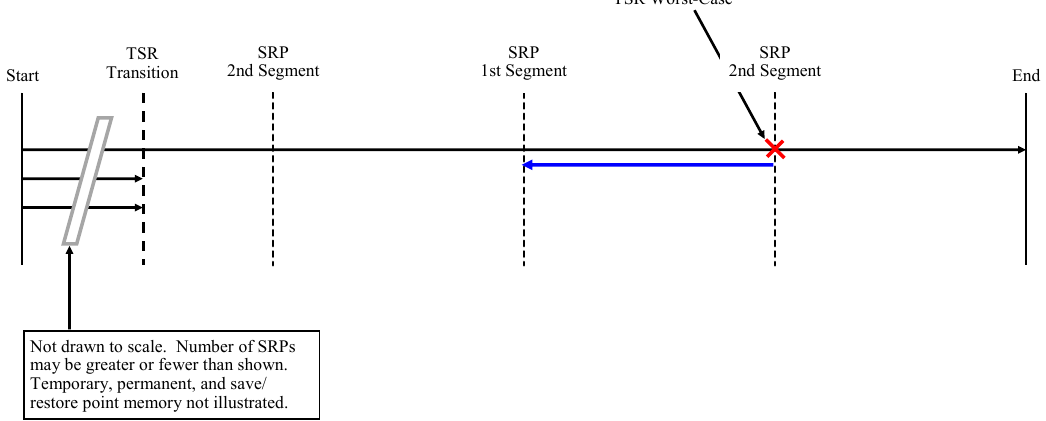
Figure A17. AHR MIPS TSR Worst-Case Early Error Timing Diagram